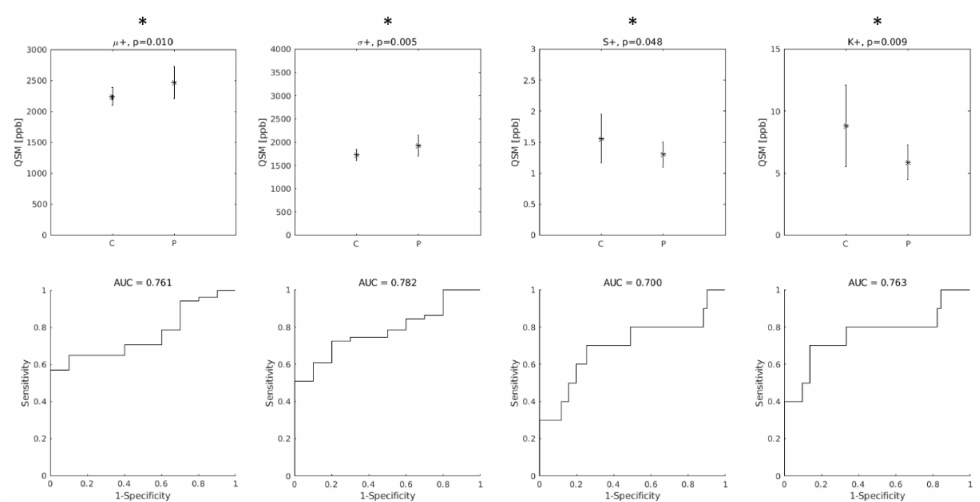
Figure 3. Top row: group differences between Controls (C) and ALS patients (P) in the distribution indices of M1 QSM positive values. µ +: mean value; σ +: standard deviation; S+: skewness; K+: kurtosis. Asterisks indicate statistically significant differences. Bottom row: diagnostic accuracy of each feature. AUC: Area Under the Receiver-Operating-Characteristic Curve.